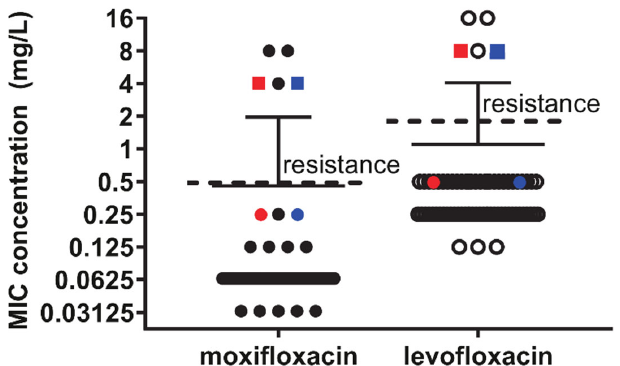
Figure 2. Minimum inhibitory concentration for M. hominis isolates for levofloxacin and moxifloxacin. Internationally agreed thresholds for resistance are shown as dotted lines and isolates above the line are resistant to the respective fluoroquinolones. Isolates with QRDR gyrA ‐ only mutations are shown (S019M as red circles and DF28 as blue circles), and MICs for these isolates following one step induction of resistance, resulting in an additional QRDR parC mutation, are shown as colored squares (S019M2R as red squares and DF282R as blue squares).